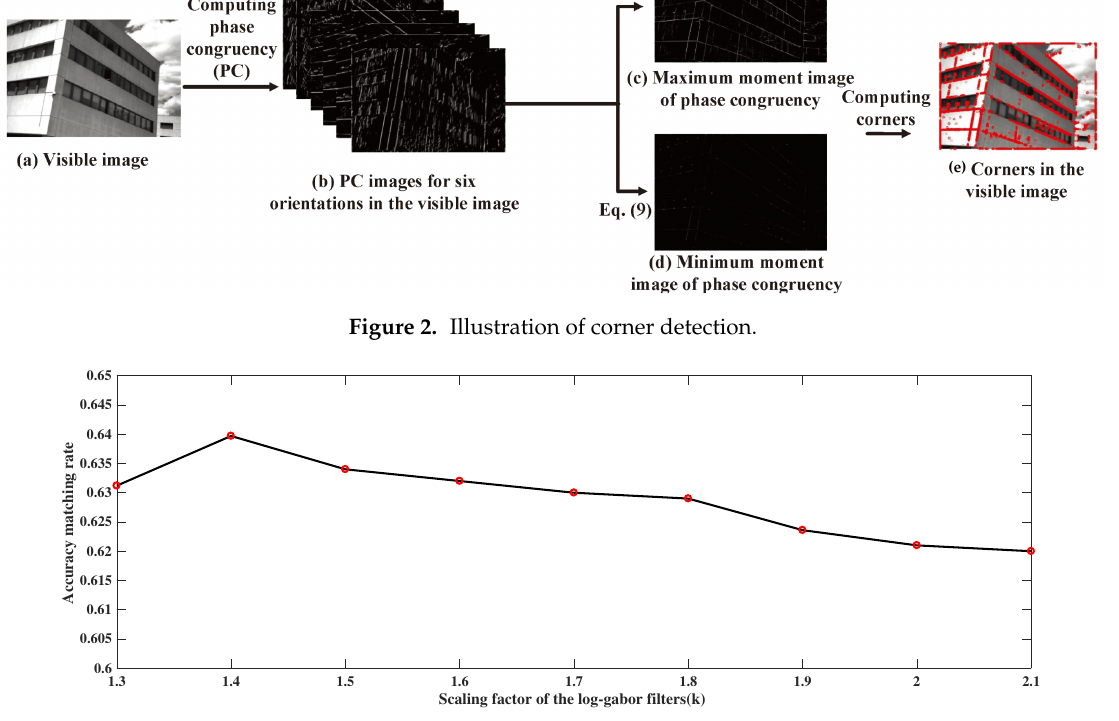
Figure 3. Trend of matching accuracy rate at different values of k